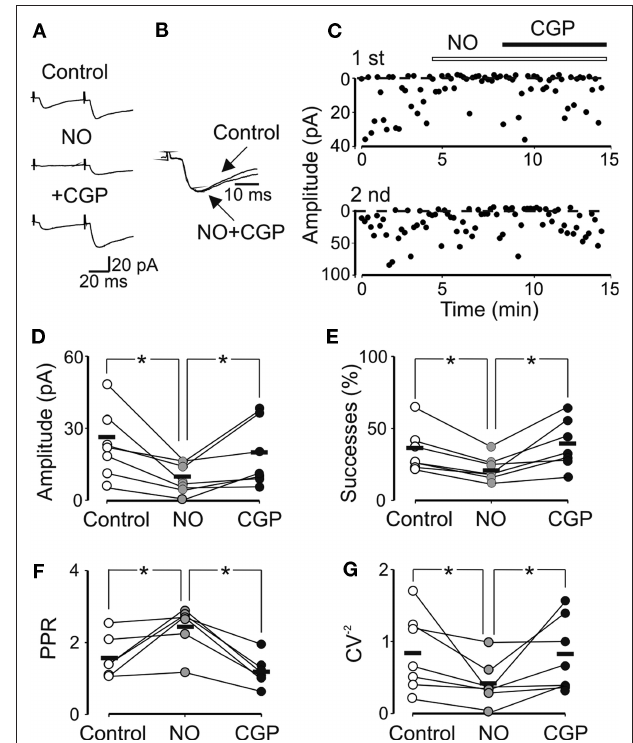
FIGURE 6 | The GAT-1 transporter blocker NO711 enhances the level of ambient GABA and reduces GABA release through the activation of presynaptic GABA receptors. (A) Average of 20 individual traces (including B failures) recorded at room temperature from a CA3 pyramidal cell in control, during NO711 (3 μ M) and NO711 plus CGP55845 (1 μ M). Note the disappearance of the fi rst response in NO711 and its reappearance after addition of CGP55845. (B) Synaptic responses obtained in control and in the presence of CGP55845 are normalized and superimposed to show NO7211- induced changes in decay kinetics. (C) Peak amplitudes of MF-evoked synaptic currents [shown in (A) ] are plotted against time before and during bath application of NO711 (open bar) and NO711 plus CGP55845 (closed bar). Summary plots of the mean amplitude (D) , success rate (E) , paired-pulse ratio (F) and inverse squared of CV (G) for six to seven individual cells recorded in control (open symbols) and during bath application of NO711 (gray circles) and NO711 plus CGP (black circles). Horizontal bars represent the mean. * p <